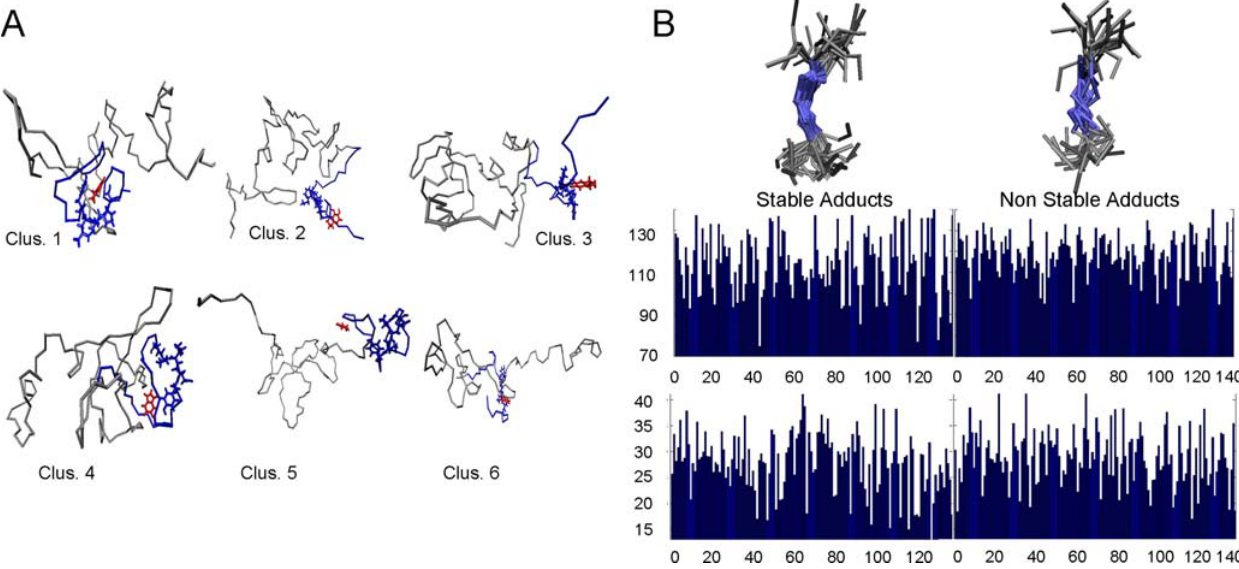
Figure 2. Molecular dynamics simulations. (A) The six most representative conformations of AS, as obtained by the cluster procedure (see Material and Methods) in complex with some of the ligands (in red color). The picture has been obtained after 6 ns MD simulations. In all circumstances, the 125–129 residues (blue licorice) are in contact with the ligands (all the resulting complexes are shown in Figure S3). (B) The 125- 126-129 C a angles show the smaller spread around its average value on all the stable complexes. Top . Conformation of the C-terminal region in the stable and unstable adducts. Middle: Average values of angles formed by C a (n 2 n + 1 2 n + 4) on stable (left) and unstable (right) adducts. Bottom: standard deviation of those angles (the average is 28 u for the stable adducts and 29 u for the unstable